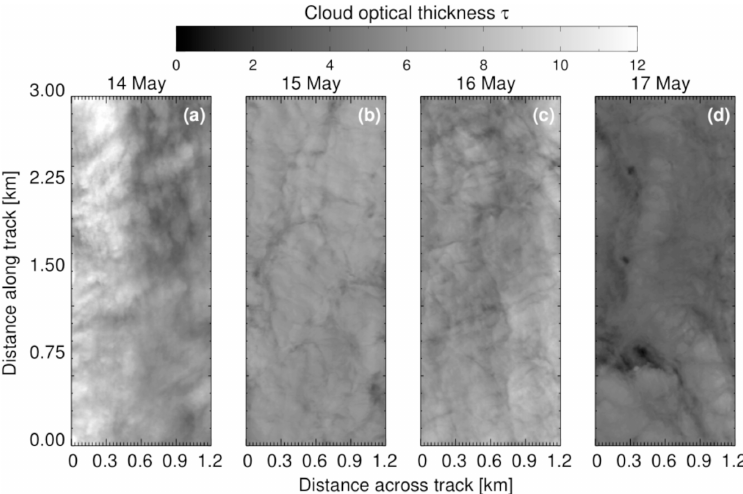
Figure 1. Exemplary selected sections (1.2 by 3.0km) of horizontal fields of τ to illustrate the daily variability of the horizontal cloud inhomogeneities during the VERDI campaign on (a) 14 May 2012, (b) 15 May 2012, (c) 16 May 2012, and (d) 17 May 2012. Data are adapted from Schäfer et al.